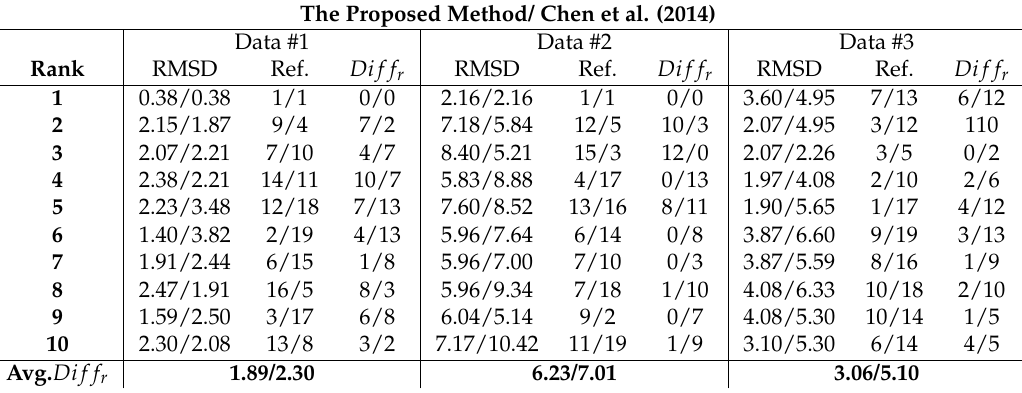
Table 2. Comparisons between retrieved rankings using the proposed method and the method by Chen et al. (2014). 1st column: RMSD of the retrieved model; 2nd column: reference ranking; 3rd column: Dif f r value. Two numbers in a pair denotes the performances of the compared methods. The Proposed Method/ Chen et al. (2014) Data #1